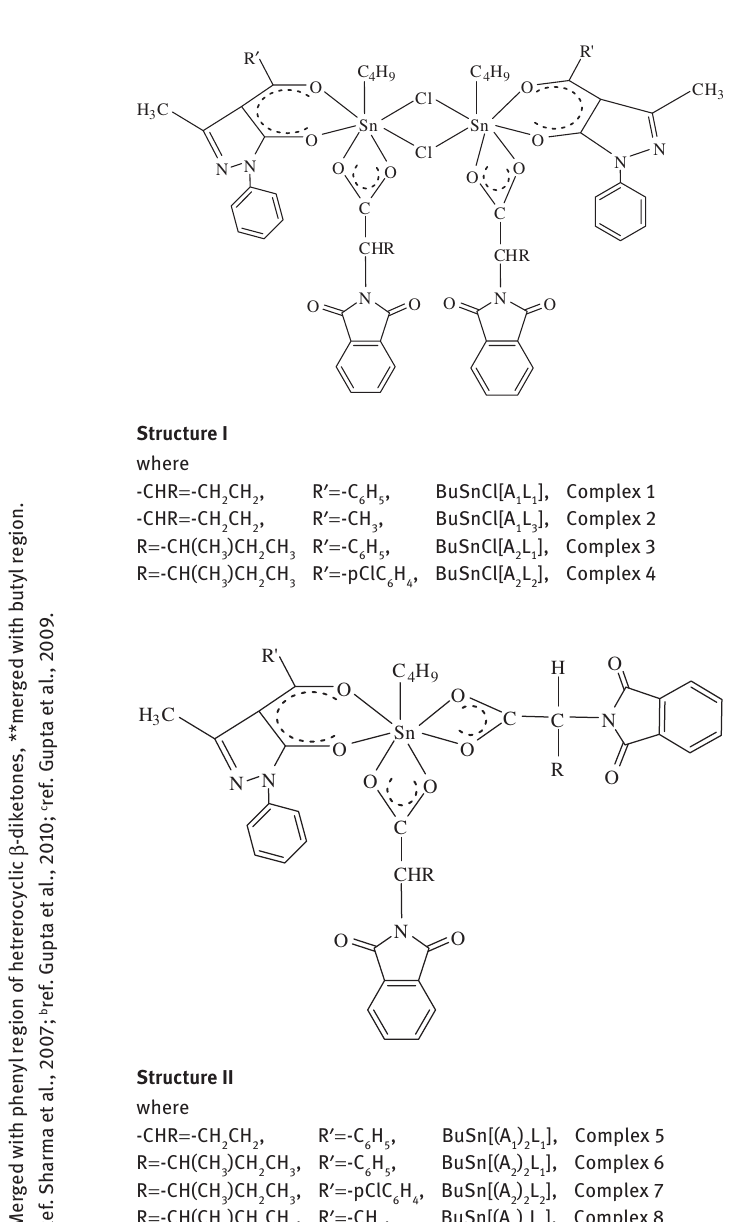
hybrid formulations of monobutyltin(IV) of the types BuSnCl[A L ], BuSnCl[A L ], and BuSn[(A ) L ] exhibit 2 1 2 2 2 2 1 signals in the region δ -509.04 to 514.37. These organic- inorganic hybrid formulations of monobutyltin(IV) contain seven coordinated tin centers as indicated by 119 Sn NMR chemical shift values, which are in agreement with the reported values for seven coordinated organotin(IV) complexes (Yin et al., 2007). 119 Sn NMR spectra of the com- plexes of the types BuSnCl[A L ] and BuSnCl[A L ] show 2 1 2 2 splitting of signals, which indicates the possibility of geo- metrical